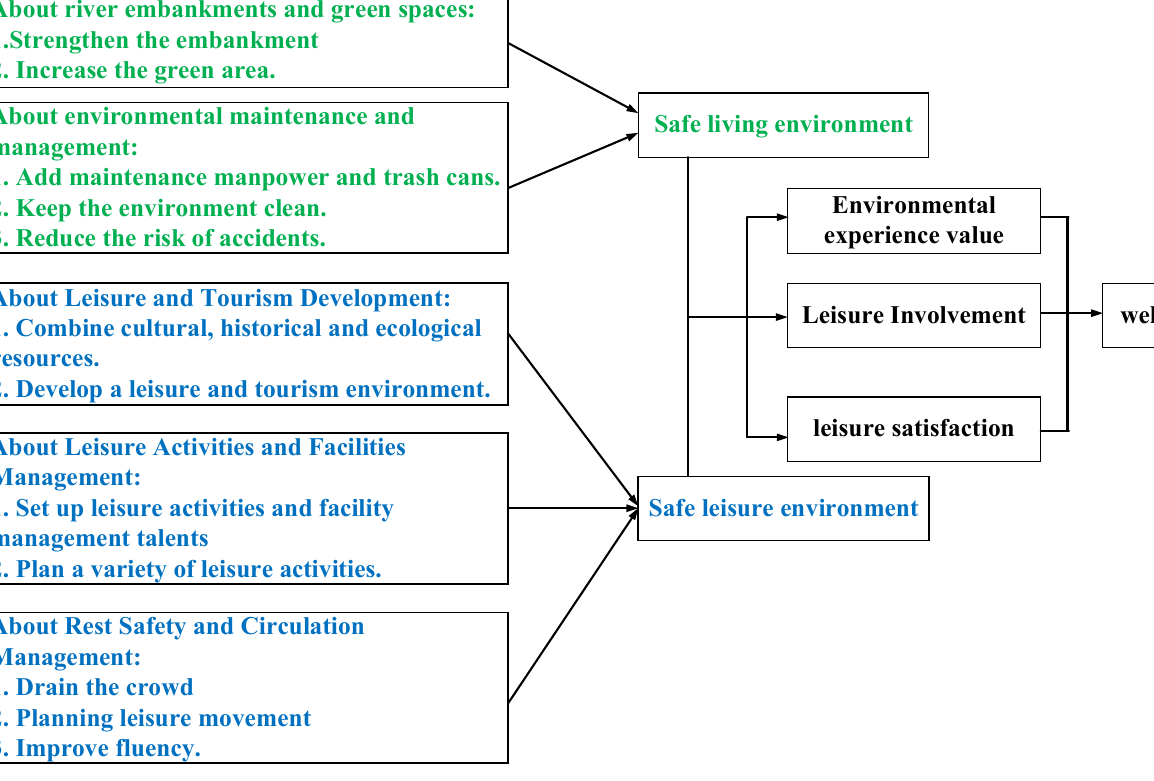
Figure 3. Developmental trend of urban river green space for leisure and recreation.